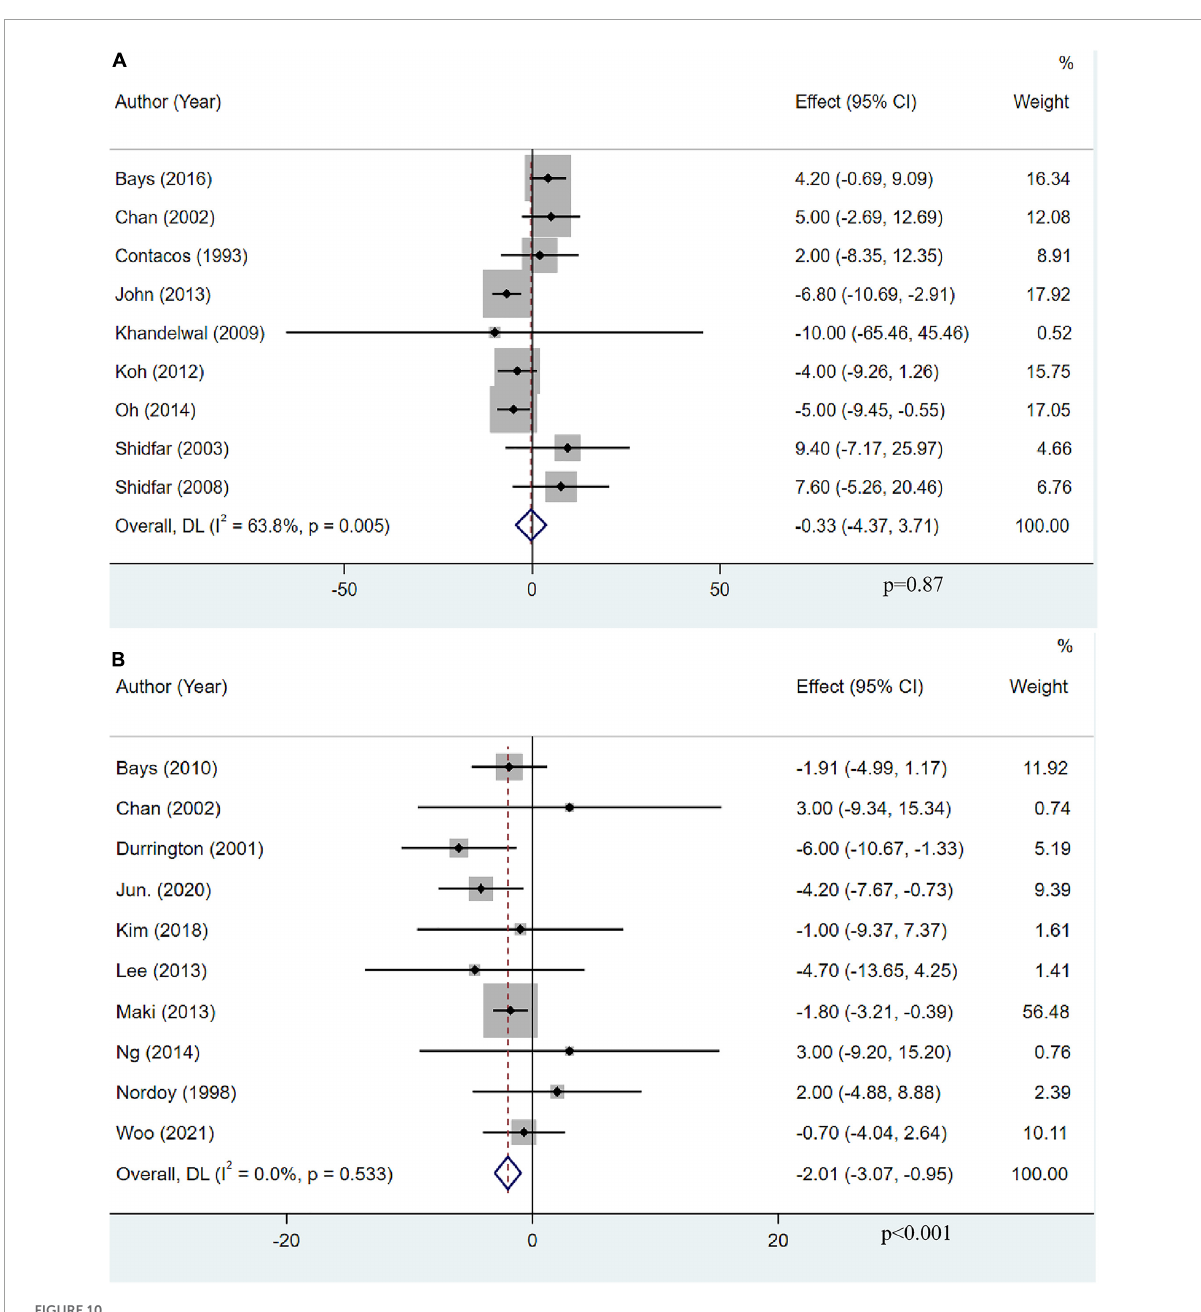
FIGURE10 The effect of OM3-FA on Apo-AI. (A) OM3-FA monotherapy; (B) Combined therapy of statins plus OM3-FA.